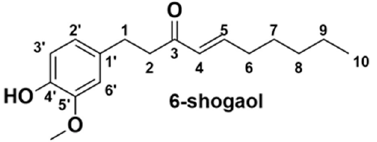
Figure 1. Structure of isolated 6-shogaol via conventional